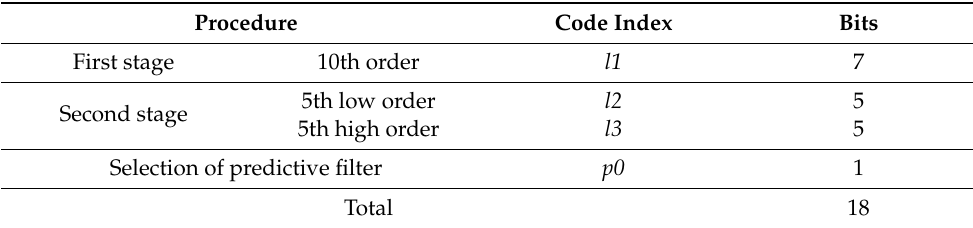
Table 2. Bit allocation of the LSF